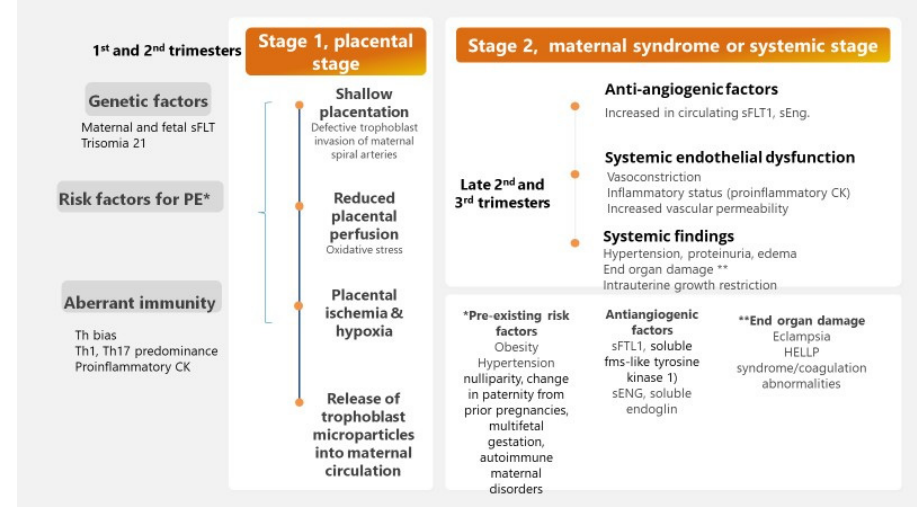
Figure 3. Schematic pathogenesis of pre-eclampsia.